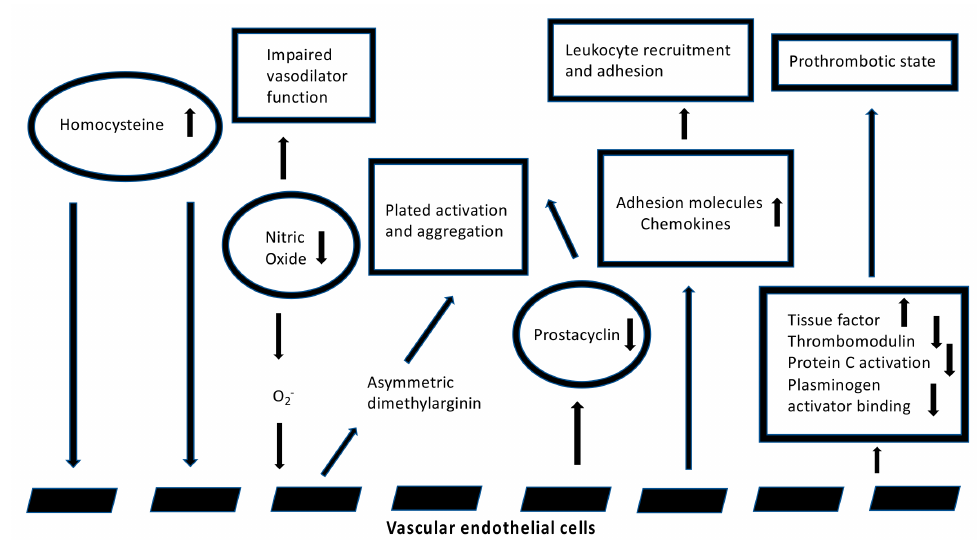
Figure 2. Mechanism of endothelial damage by HHcy (modified by Weiss, N. et al., Vascular Medicine 2002, 7 , 227–239).